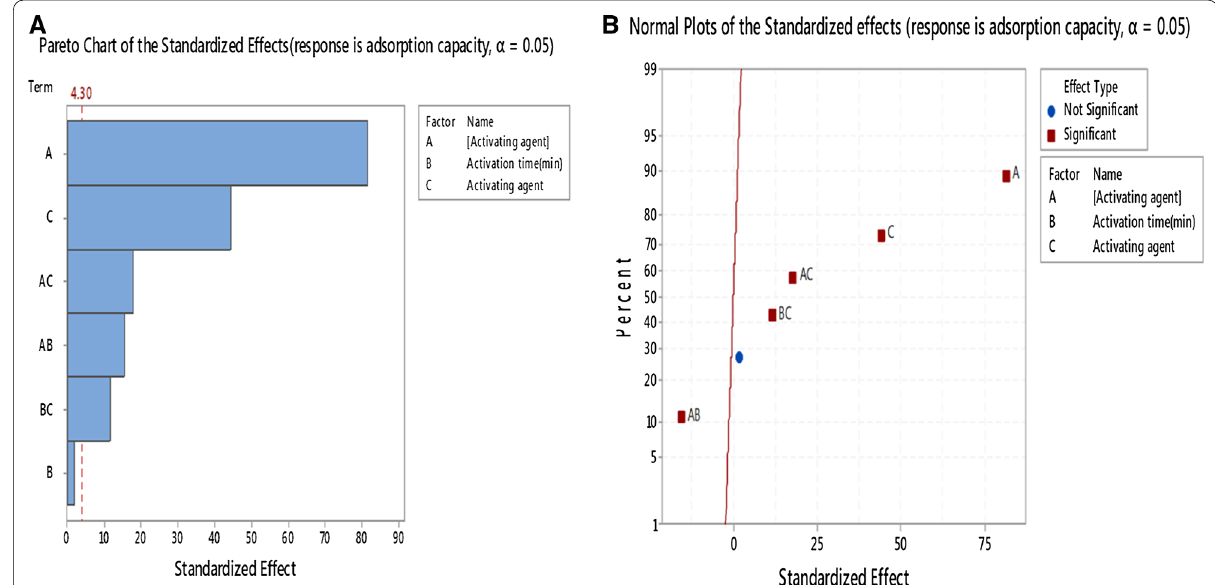
Fig. 2 a , b Pareto plots and normal plot of standardized effects of model parameters on the DGPAC adsorption